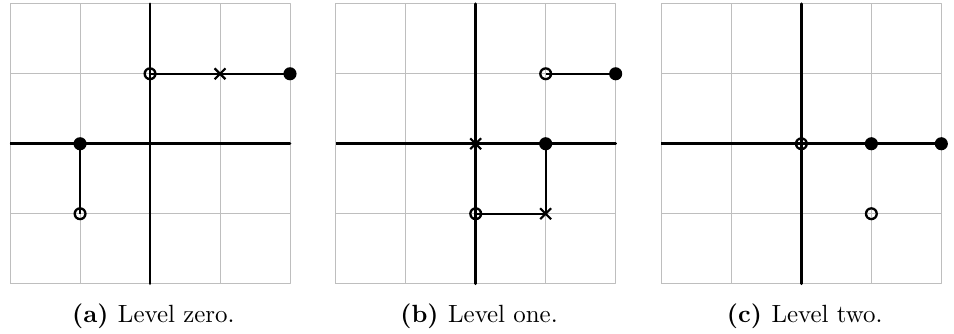
Figure 10. Exponential factors of the fundamental representation in direction 1. The two crosses in the middle (cid:12)gure correspond to two possible paths.